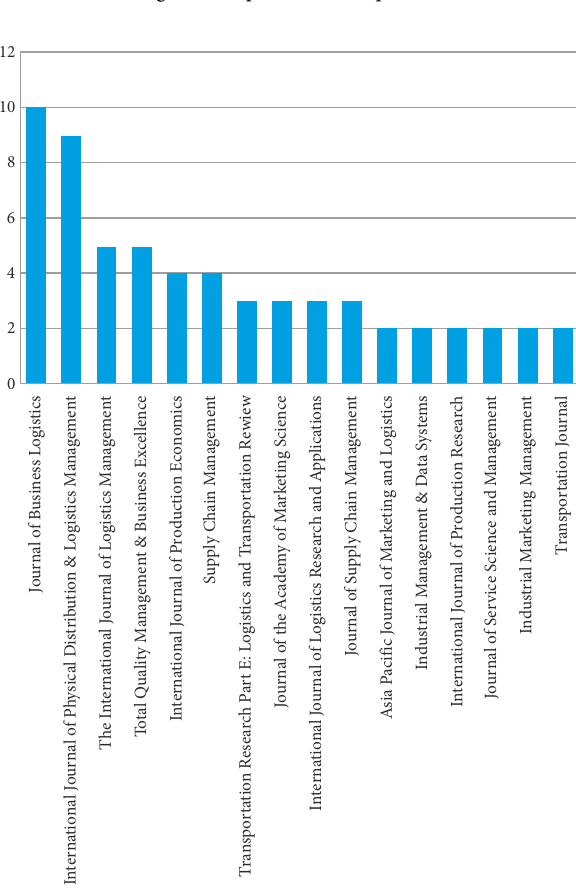
Figure 2. Number of papers in